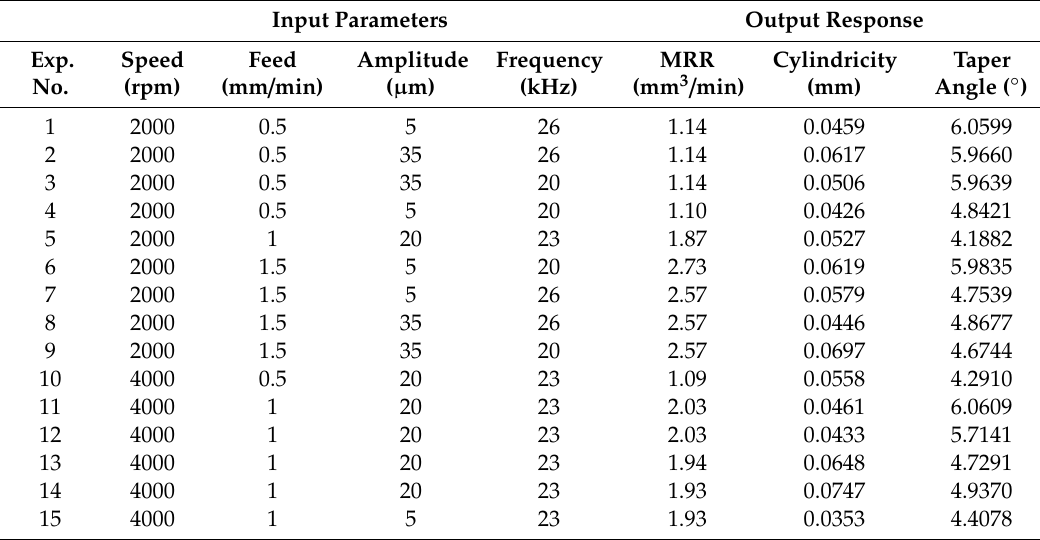
Figure 7. Image obtained through an optical microscope. ( a ) Top side of the hole (experiment #12). ( b ) Top side of the hole (experiment #14). ( c ) Bottom side of the hole (experiment #12). ( d ) Bottom side of the hole (experiment #14). Table 4. Design table with output